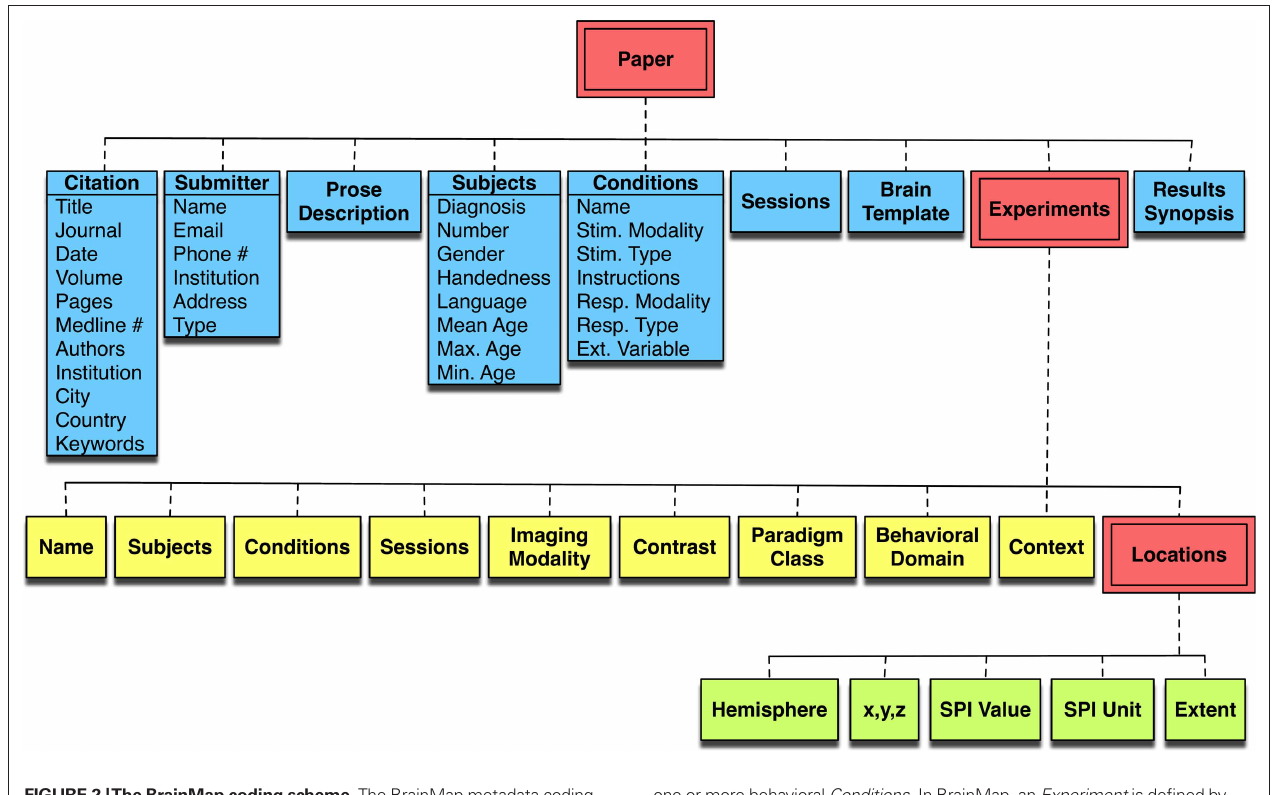
FIGURE 2 | The BrainMap coding scheme. The BrainMap metadata coding scheme follows a hierarchy naturally occurring within the brain mapping literature. Every Paper reports experimental results drawn from one or more subject groups, the members of which have been functionally imaged during